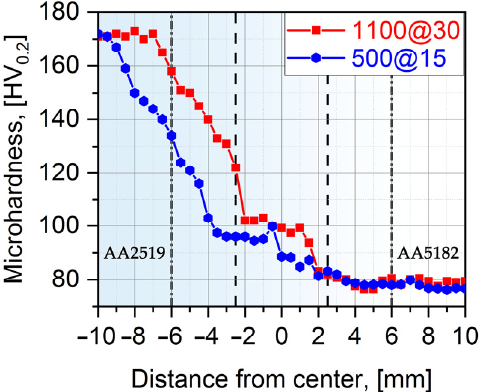
Figure 4. The microhardness profiles across the welds. For the sake of clarity, the probe and shoulder diameters (5 and 12 mm, respectively) were indicated with dash lines.